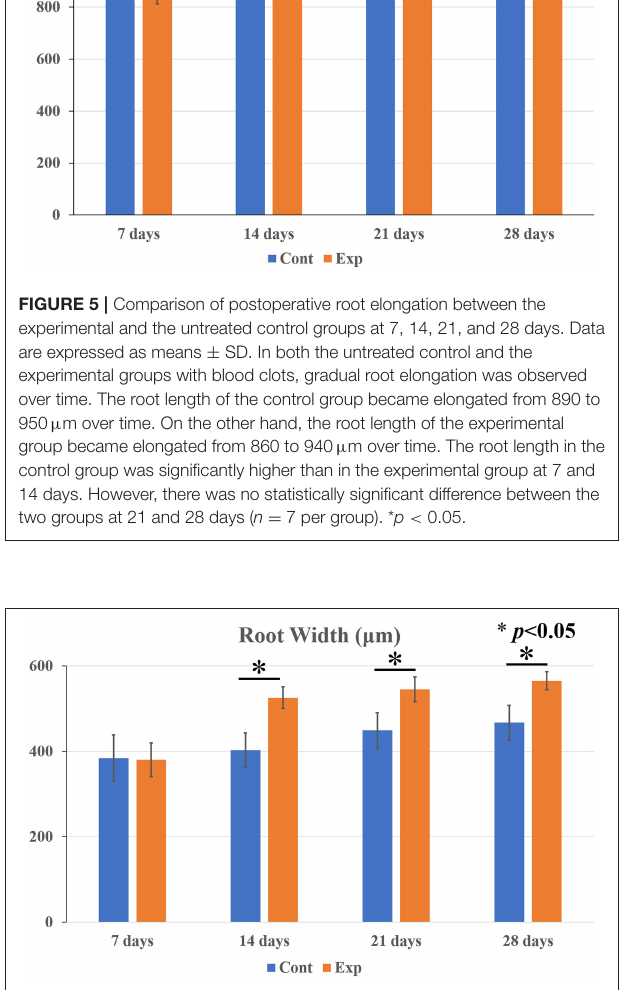
FIGURE 6 | Comparison of postoperative root width between the experimental and the control groups at 7, 14, 21, and 28 days. Data are expressed as means ± SD. In both the untreated control and the experimental groups with blood clots, gradually thickened roots were observed over time. The root width in the control group increased from 380 to 450 µ m, and that in the experimental group increased from 410 to 530 µ m. There was not a statistically significant difference in the root width between the two groups at 7 days. However, the root width in the experimental group was significantly thicker than in the control group at 14, 21, and 28 days ( n = 7 per group). * p <